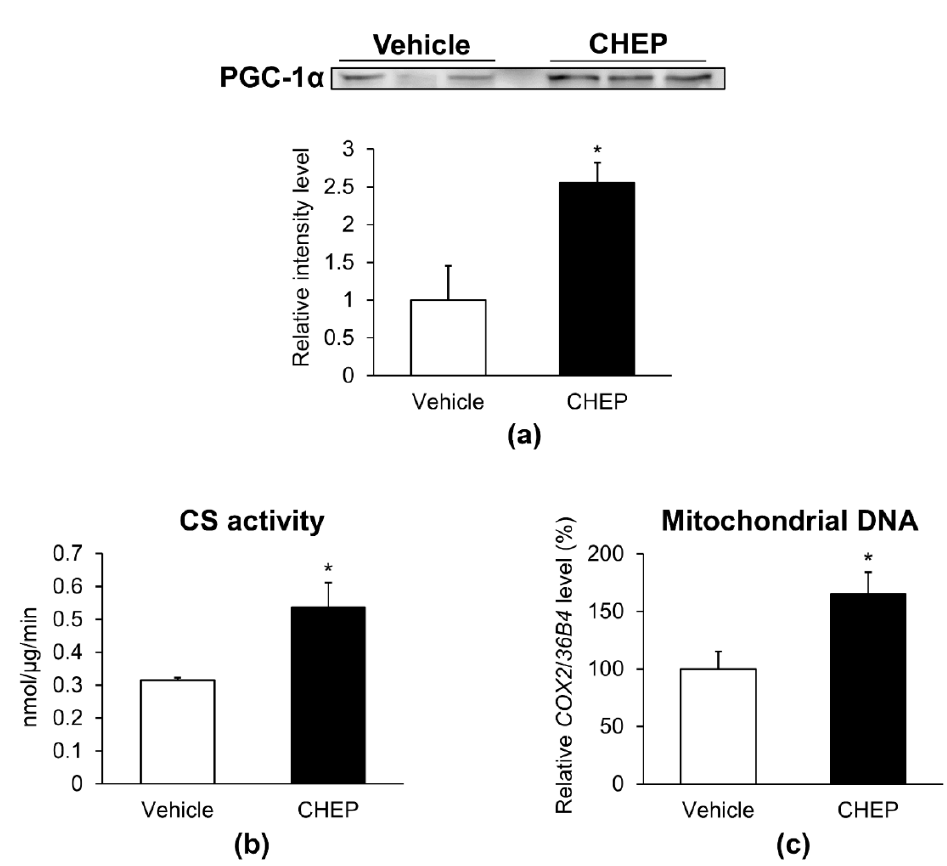
Figure 1. CHEP increases the amount of PGC-1 α protein and mitochondria in C2C12 myotubes. Cells were incubated with vehicle (DMSO) or 37 µg/mL of CHEP for 24 h. ( a ) PGC-1 α protein expression was evaluated using western blotting. Total PGC-1 α protein levels were normalized to the total protein amount in the membrane as obtained after Ponceau S staining. Relative protein levels are expressed compared to those of cells treated with the vehicle. ( b ) CS activity was normalized to the protein content in the homogenate. ( c ) Mitochondrial DNA content, expressed as a percentage with respect to that in vehicle-treated cells. Relative mitochondrial DNA copy number was calculated as the ratio of COX2 (mitochondrial) to 36B4 (nuclear) gene expression level using real-time PCR. Values are expressed as mean ± SEM ( n = 3–7); * p < 0.05 vs. vehicle. CHEP, Citrus hassaku extract powder; PGC-1 α , peroxisome proliferator-activated receptor- γ coactivator-1 α ; CS, citrate synthase; COX2 , cytochrome c oxidase subunit II; SEM, standard error of the mean.